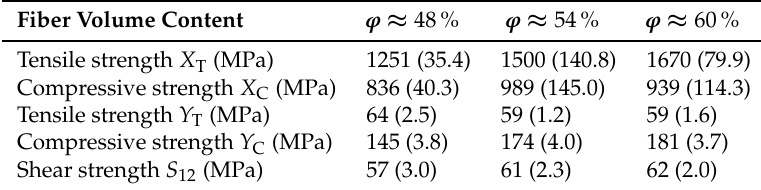
Table 9. Reference samples—material strength at different fiber volume contents (median values and interquartile range (IQR) in brackets).